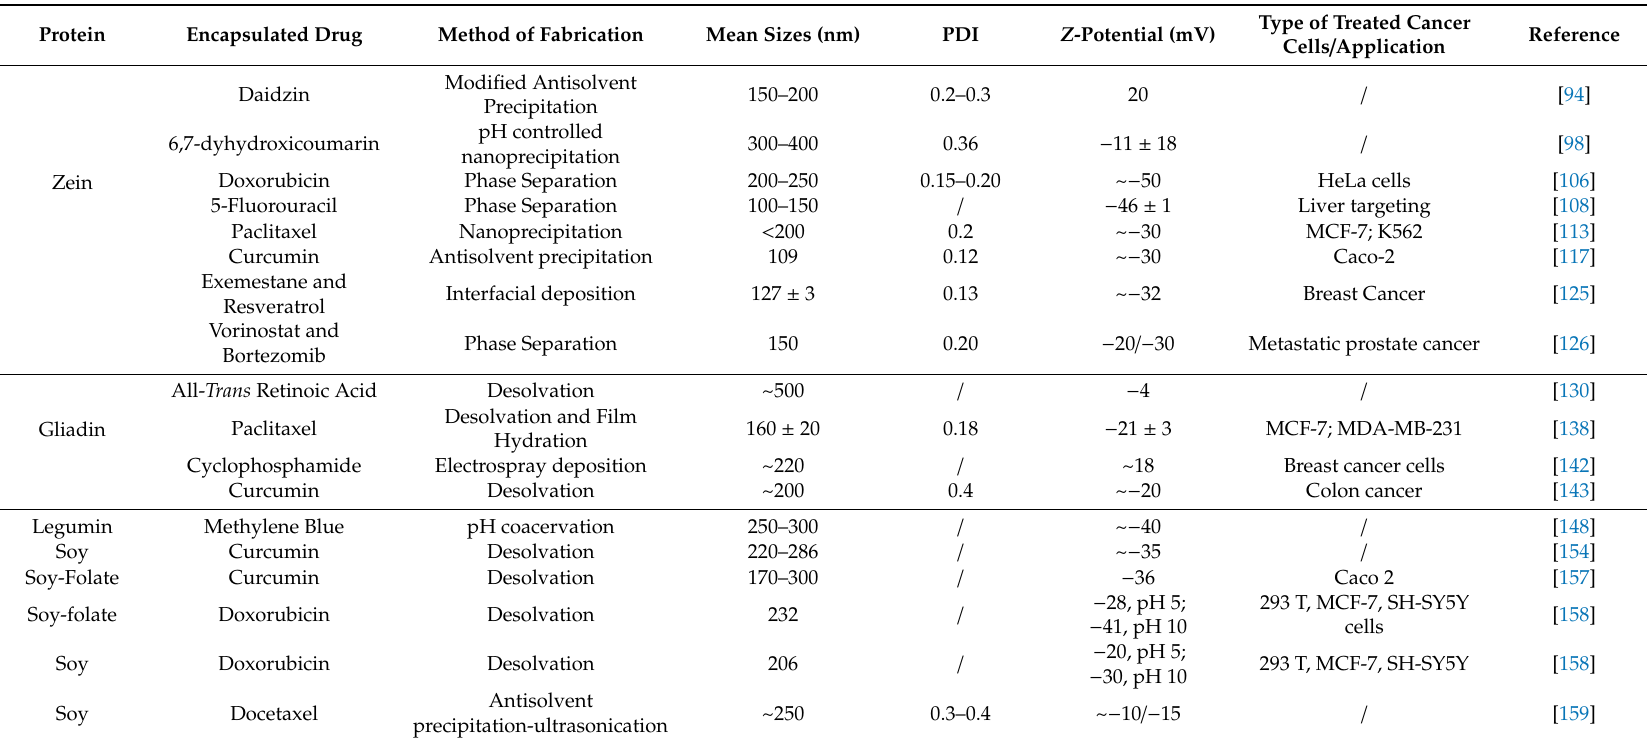
Table 1. Composition, physico-chemical characteristics and antitumor application of vegetal protein-based